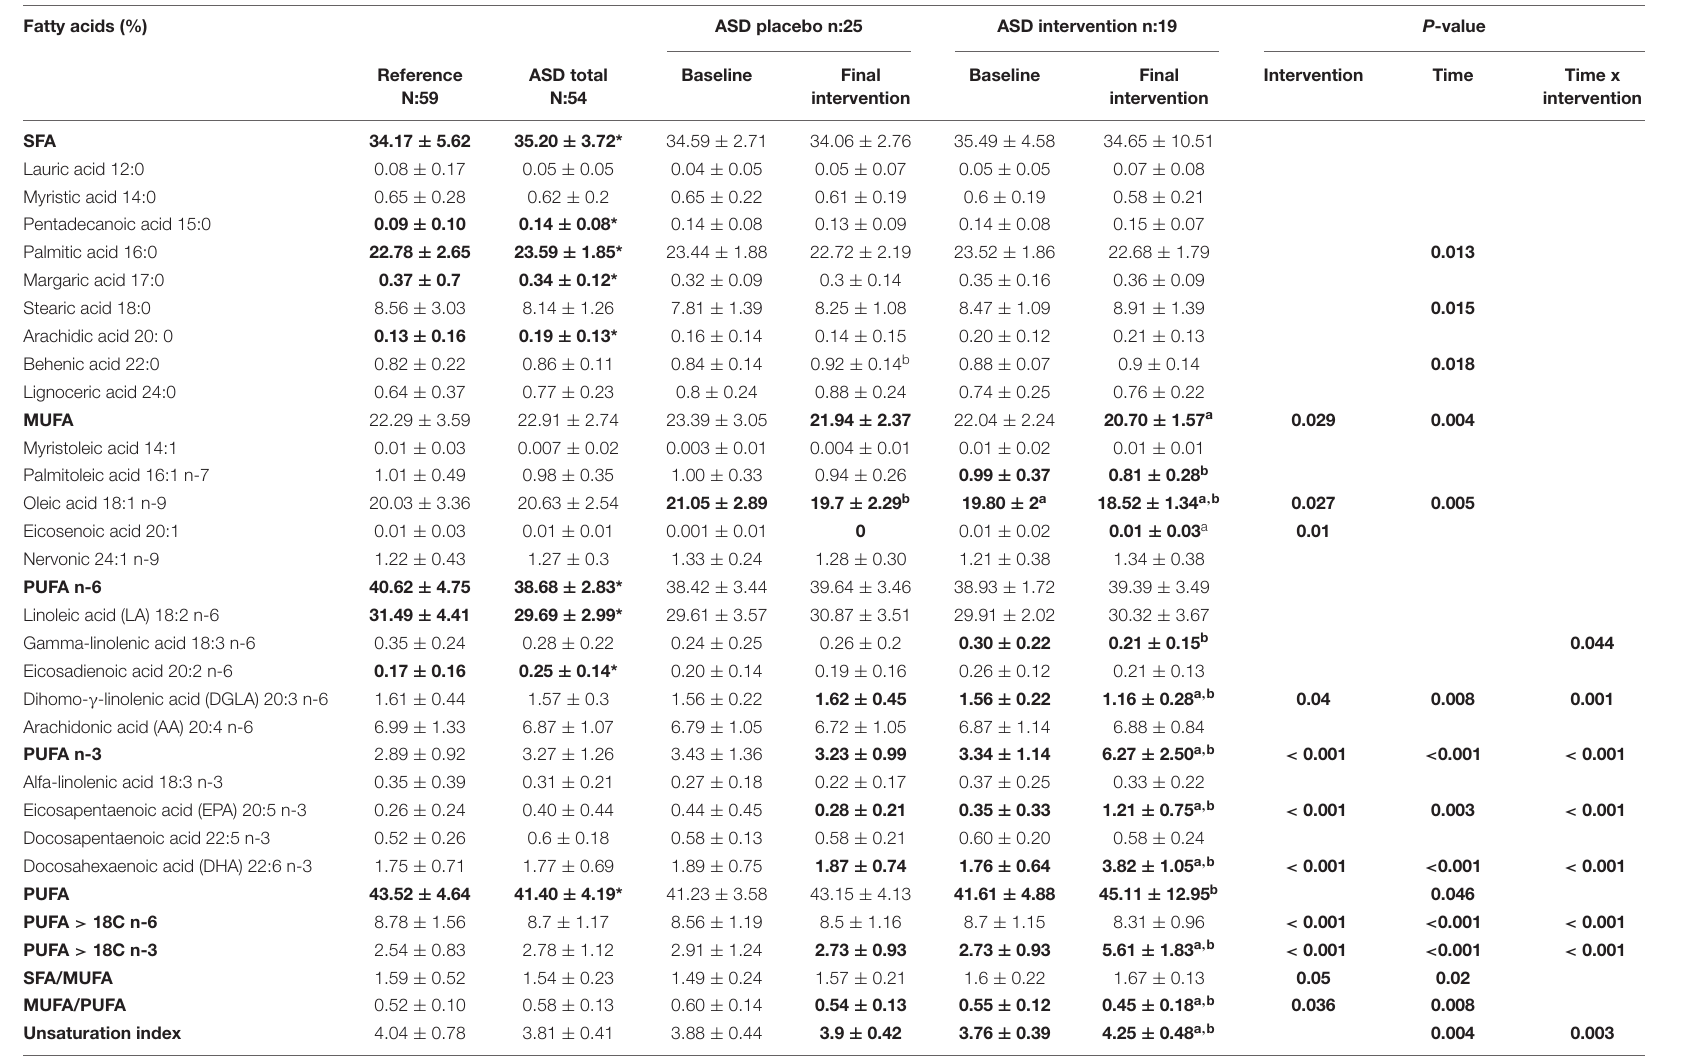
TABLE 3 | Comparison of plasma fatty acid profile between reference group and ASD children. Fatty acids